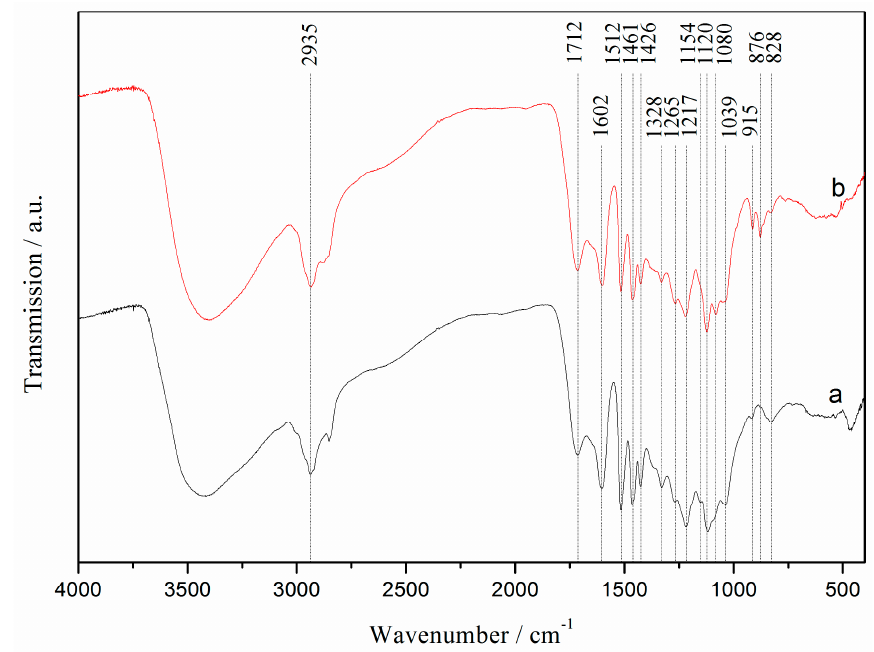
Figure 4. FT-IR spectra of the soda lignin (a; L0) and catalyzed-soda lignin (b; L4).